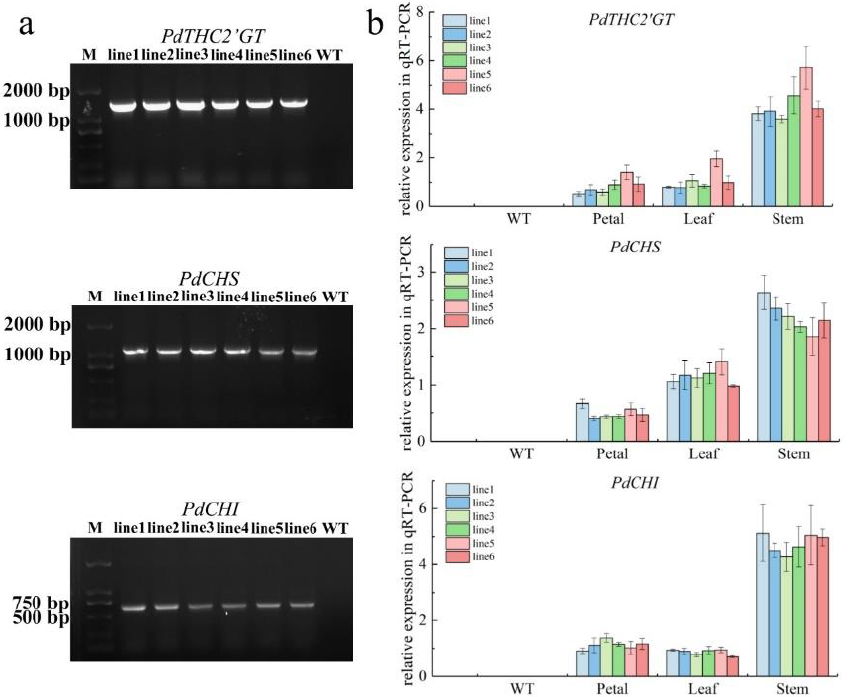
Figure 6. Positive detection of transgenic tobacco. ( a ) Electropherogram of positive PCR detection in transgenic tobacco lines. ( b ) Temporal and spatial expression patterns of PdTHC2’GT , PdCHS, and PdCHI in the six transgenic tobacco lines. Data are the means ( ± SD) from three biological replicates. The phenotypes of tobacco after flowering were observed. After flowering, the red color of six tobacco lines with overexpressed PdTHC2 (cid:48) GT was lighter than that of WT tobacco, and the petals were not uniformly lighter, among which the petals of line5 and line6 appeared yellow. After the flowering of the tobacco with overexpressed PdCHS , the color of the six tobacco lines was slightly darker than that of WT tobacco. After flowering, the red color of the six tobacco lines overexpressed with PdCHI was darker than that of WT tobacco and deeper than that of the tobacco lines with overexpressed PdCHS (Figure 7a). qRT-PCR was used to analyze the changes in NtCHS and NtCHI in tobacco petals with overexpressed PdTHC2’GT , PdCHS, and PdCHI . The results showed that after overexpression of PdTHC2 (cid:48) GT , the expression of NtCHS gen in tobacco petals was obviously upregulated (Figure 7b), and the expression of NtCHI was obviously downregulated (Figure 7c). The expression of NtCHI in tobacco petals was significantly upregulated after overexpression of PdCHS (Figure 7d). The expression of NtCHS in tobacco petals was significantly upregulated after overexpression of PdCHI (Figure 7e). However, since there is no THC2’GT gene in tobacco, the effect of overexpression of CHS and CHI on the THC2’GT gene was not clear. This indicated that the overexpression of PdTHC2’GT , PdCHS, and PdCHI in tobacco did affect the expression of genes in the tobacco flavonoid synthesis